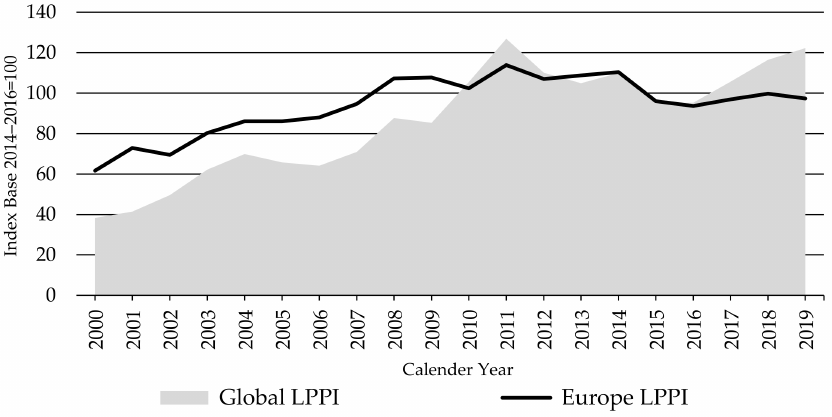
Figure 10. The Global and Europe Lambs Producer Price Indices LPPIs, Source: own illustration. Sheep production systems in Europe tend to be small, high-cost, and diverse compared to those in Oceania, resulting in low profitability, despite government protection and payments. Consequently, there has been an average 1.9% per annum decline in the EU production over the last two decades. Furthermore, lamb has increasingly become a marginal meat in the consumer basket in Europe, seasonally consumed at Easter and Christmas [51]. Per capita consumption in certain major meat markets, such as